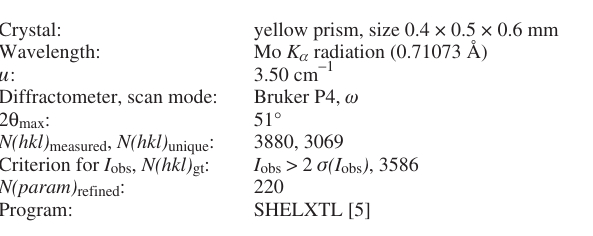
Table 1. Data collection and handling.